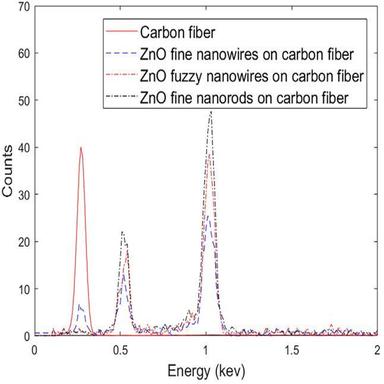
EDX spectra of ZnO nanowires on carbon fibers.